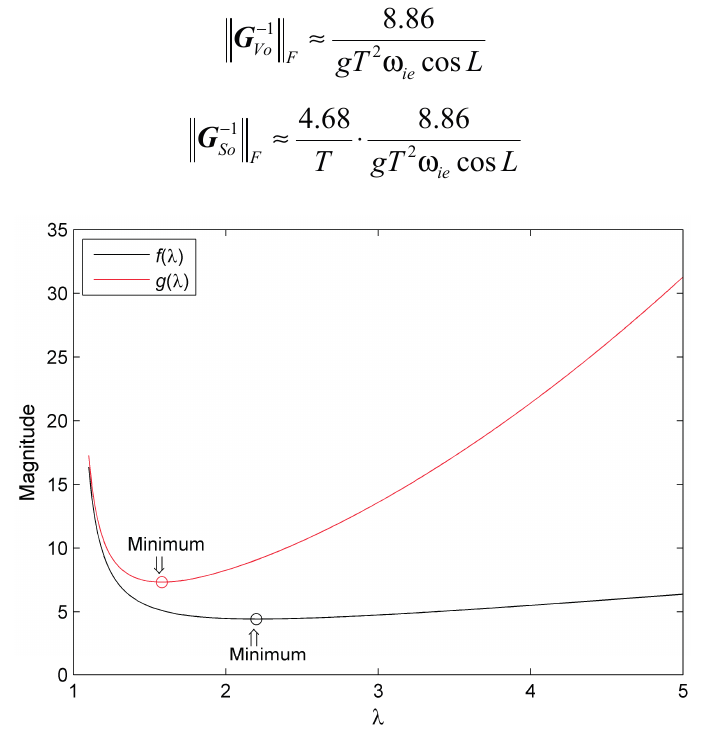
Figure 2. The graphs of functions ( ) f λ and ( ) g λ